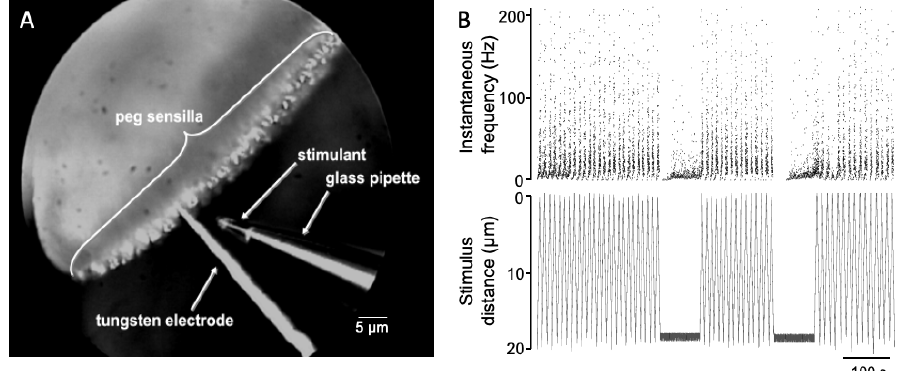
Figure 6. Spiking activity closely follows travel of stimulus pipette. ( A ) Example of a repeated stimulation with a hexanol-filled pipette moved between 0 and 20 microns of the tip of a recorded peg sensillum. ( B ) Instantaneous spiking frequency of combined peg sensillum neurons (top) and distance of pipette from peg tip (bottom).